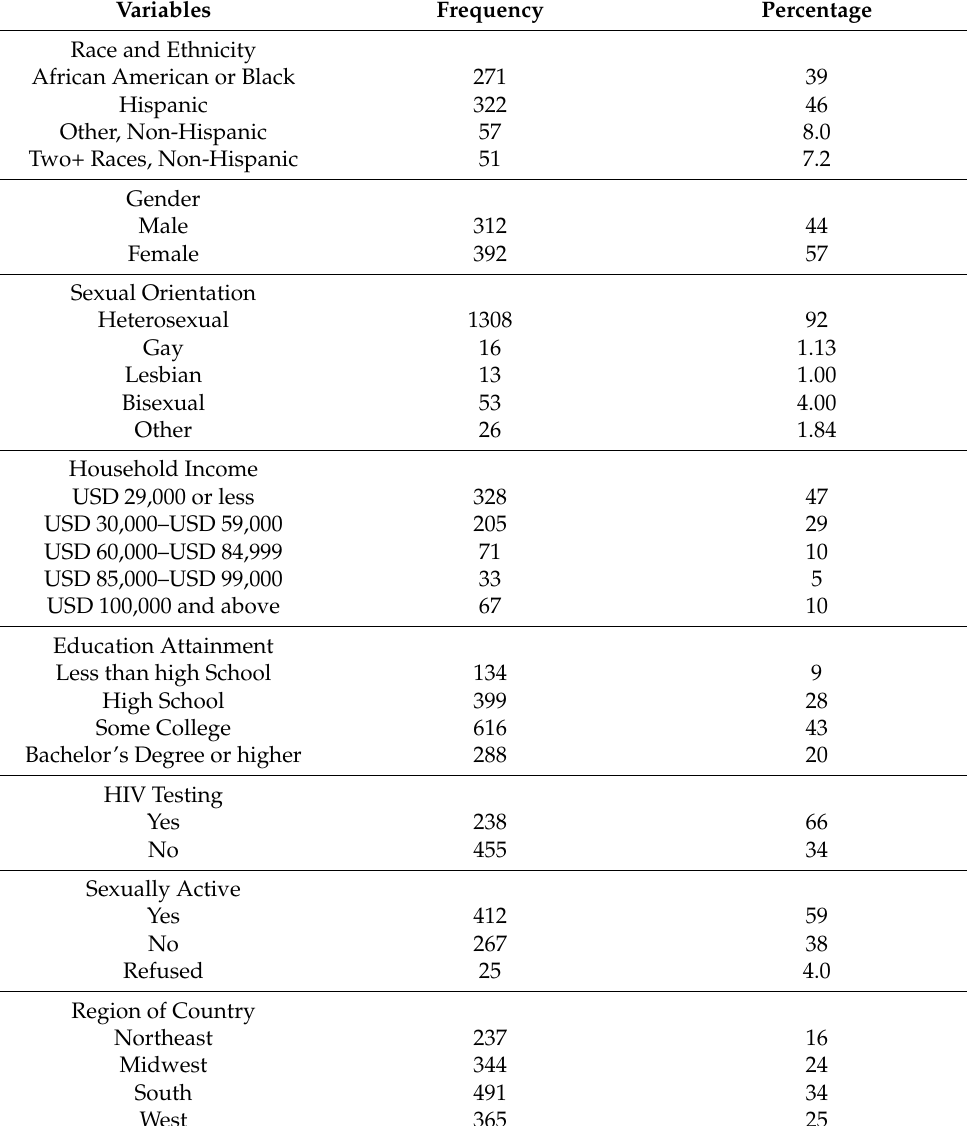
Table 1. Sample characteristics ( n =